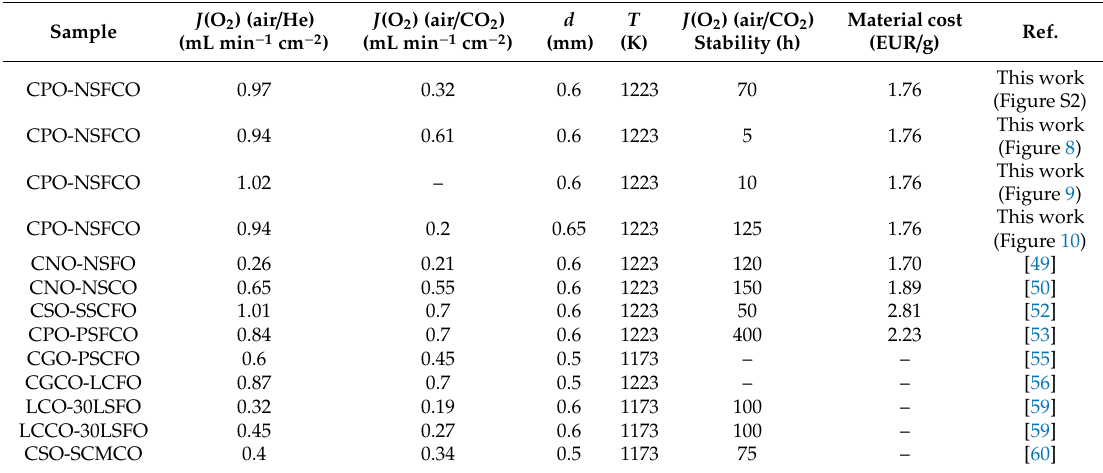
Table 1. Summary of the reported promising oxygen permeation fluxes of various dual-phase membranes.